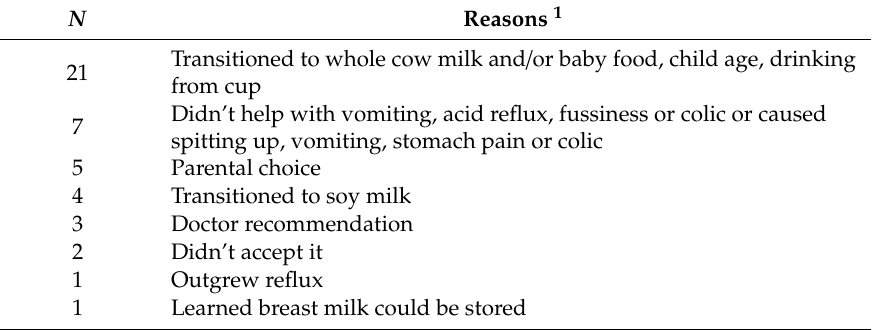
Table 8. Reasons children with FXS were stopped being fed soy-based formulas.